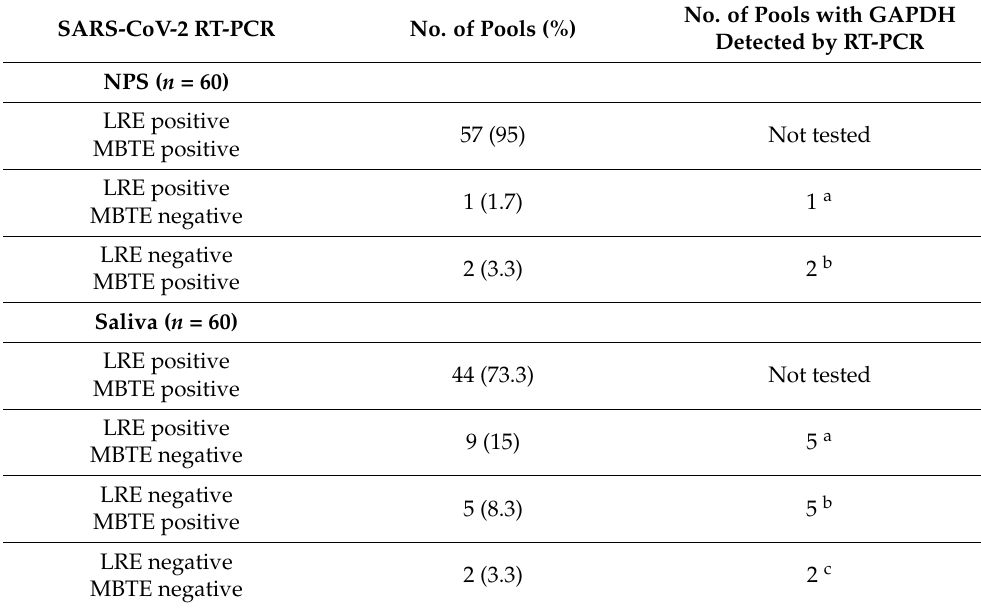
Table 2. Pooled samples that tested negative for SARS-CoV-2 in at least one extraction method.